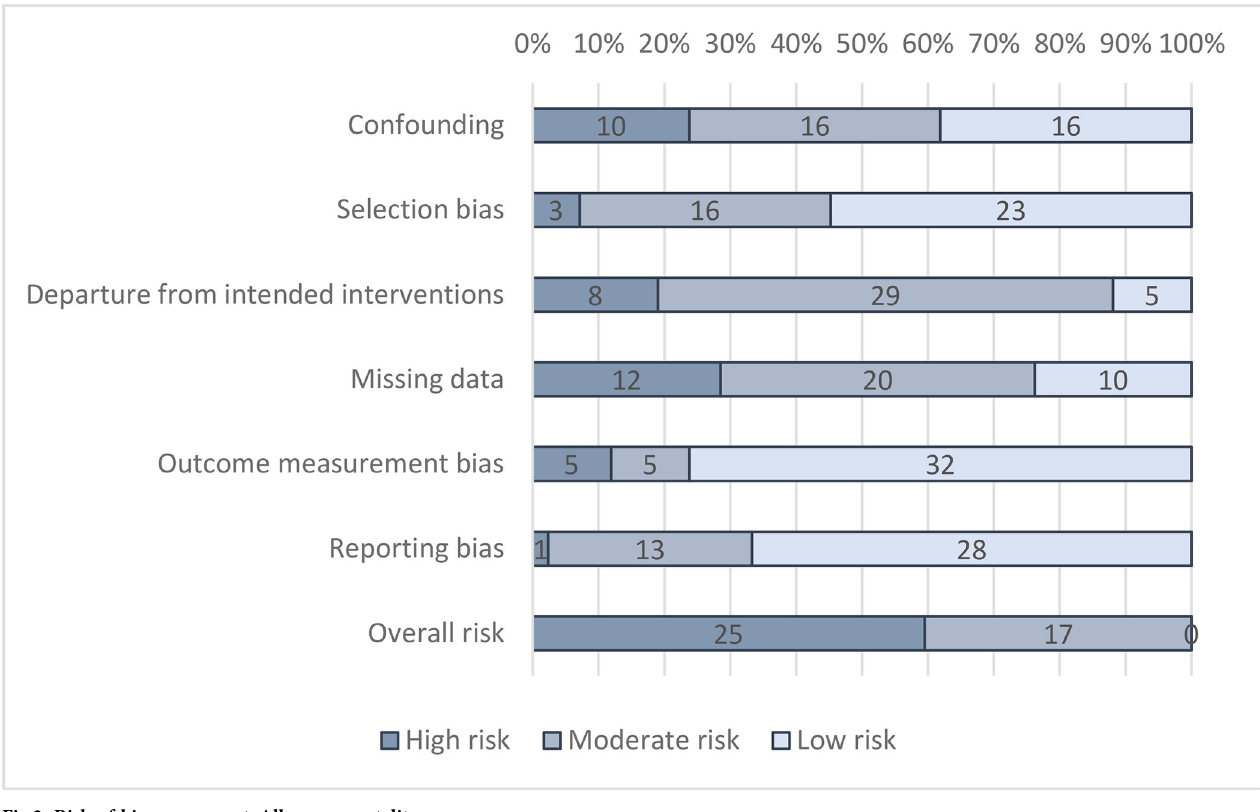
Fig 2. Risk-of-bias assessment: All-cause